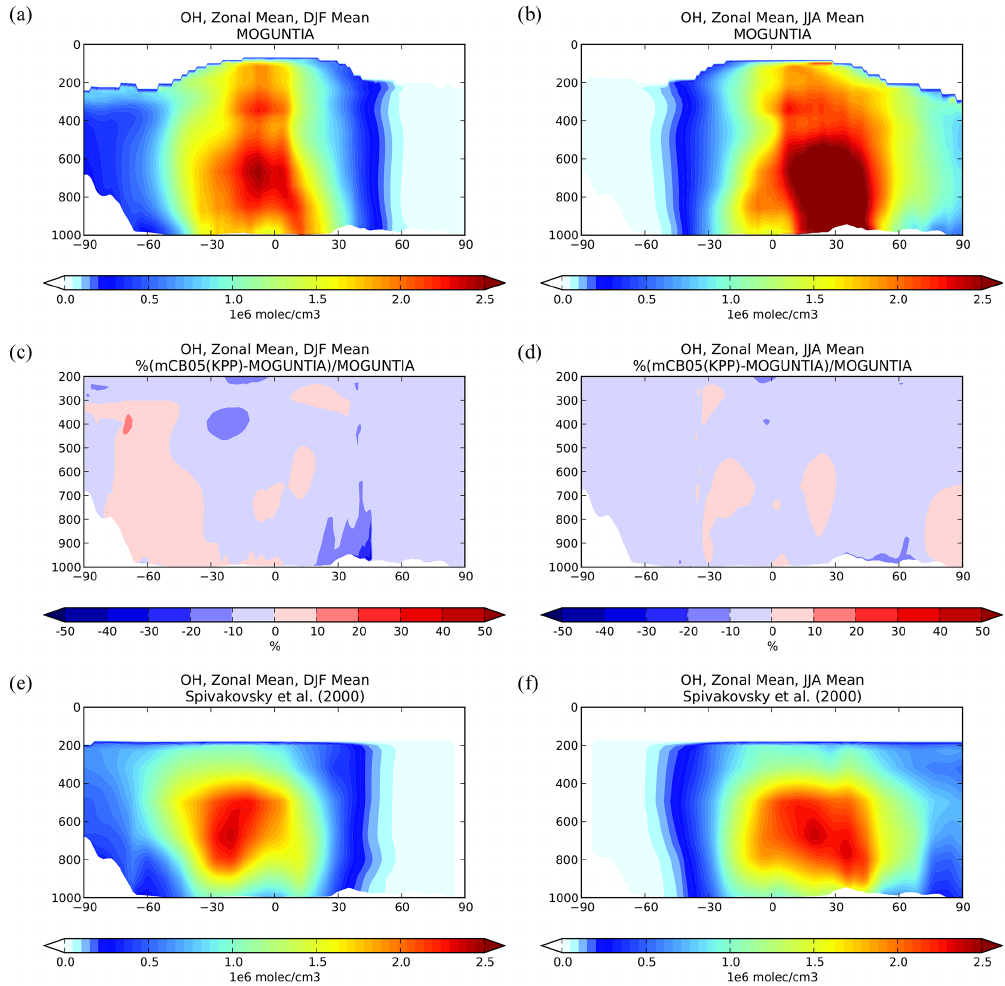
Figure 4. Zonal mean OH mixing ratios for December–January–February (DJF; a, c, e ) and June–July–August (JJA; b, d, f ) 2006, as simulated by the TM5-MP model with the MOGUNTIA chemistry scheme (a, b) . The differences (%) between the mCB05(KPP) and the MOGUNTIA chemical configuration (c, d) and the optimized climatological average from Spivakovsky et al. (2000) up to 200hPa (e, f)